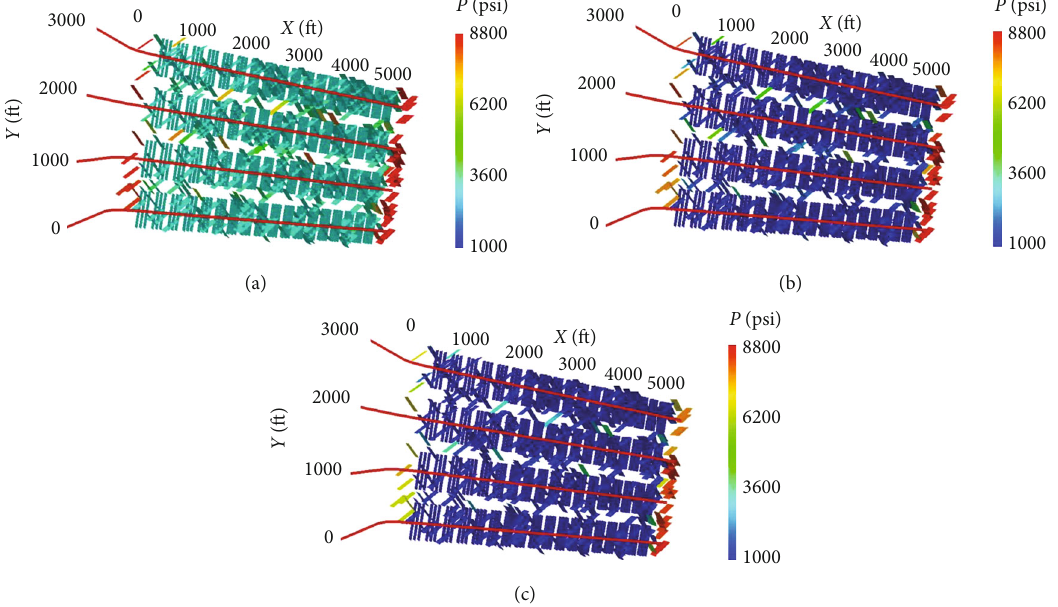
Figure 16: Pressure distributions in the fractures for the optimal well spacing scenario: (a) after 1 year, (b) after 5 years, and (c) after 20